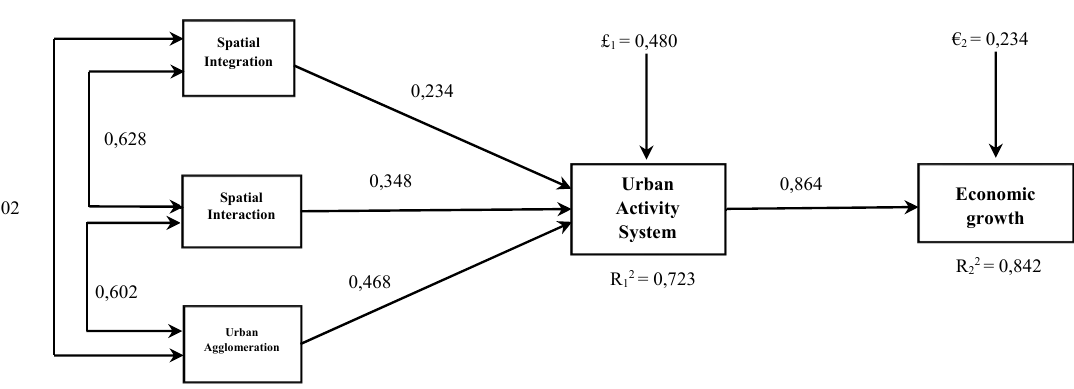
Figure 14. The Relationship of Spatial Integration, Spatial Interaction and Urban Agglomeration to Economic Growth in the Mamminasata Metropolitan Suburban. Source: author elaboration.